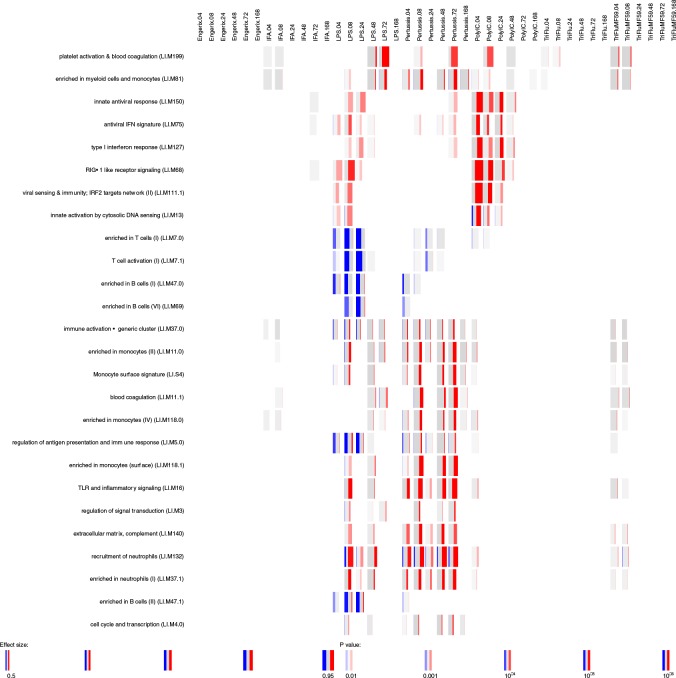
Gene-set enrichment analysis in blood data set.Enrichment scores were calculated for blood transcriptional modules defined by Li et al. (2014) using R package tmod (version 0.34) (US National Library of Medicine, 2004). The modules (in rows) are described by the titles followed by the original IDs. Each column corresponds to a different vaccine, TLR agonist or adjuvant and to a different time point. The size of each miniature graphics shows how strong the enrichment is. The intensity of the colours indicates the p-value (stronger colours lower p-value). The amount of colour shows the fraction of genes in each module that are significantly up- (red) or downregulated (blue). Only the modules with p-value for enrichment of <10−6 and an effect size of for the gene-set enrichment (AUC)of >0.5 are shown.